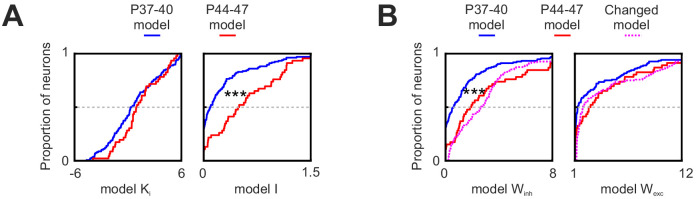
Changes in PSS inhibition parameters with development and model parameter settings for the different model instantiations.(A) Changes in the two model variables that control PSS inhibition (KI, left; I, right) with development, determined by fitting the model to data from the two age groups, with the V1 stage set to the appropriate age as well. While there are significant changes in I, changes in KI are not significant. ***p<0.001. (B) Cumulative distribution plots of Winh (left) and Wexc (right) in the two age groups and for the model instantiations used for Figure 8B,C and E. ***p<0.001.